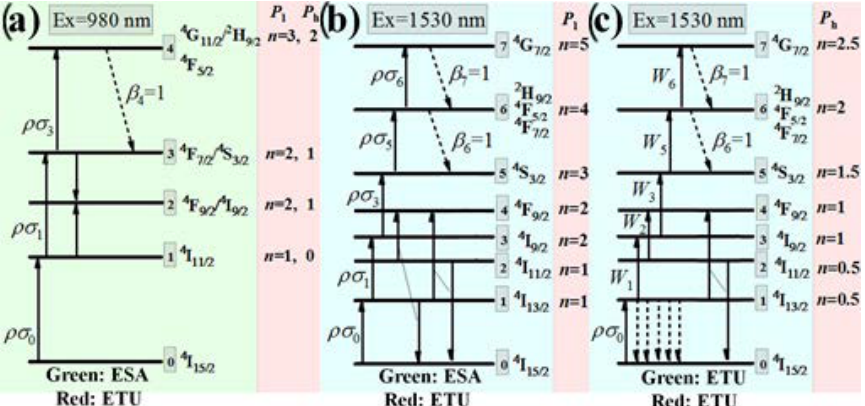
Figure 6. Simplified energy levels of Er 3+ with the dominant upconversion pathways upon ( a ) 980 nm excitation, ( b ) weak 1530 nm excitation, and ( c ) strong 1530 nm